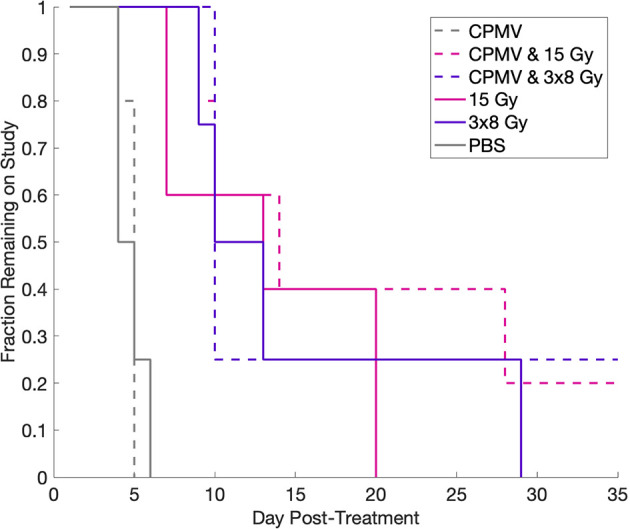
Kaplan-Meier Curve. Kaplan-Meier curve demonstrating the changes in fraction on study for each treatment as a function of days post-treatment. Control and Cowpea mosaic virus (CPMV) cohorts lack separation, whereas all of the radiation cohorts are separated from control and CPMV, but not from each other. Using the log-rank (Mantel-Cox) test, we determined that treatment did significantly change survival, however, using multiple comparison adjustment and comparing two curves to each other, only control versus 15 Gy and control versus 15 Gy + CPMV were statistically significantly different.